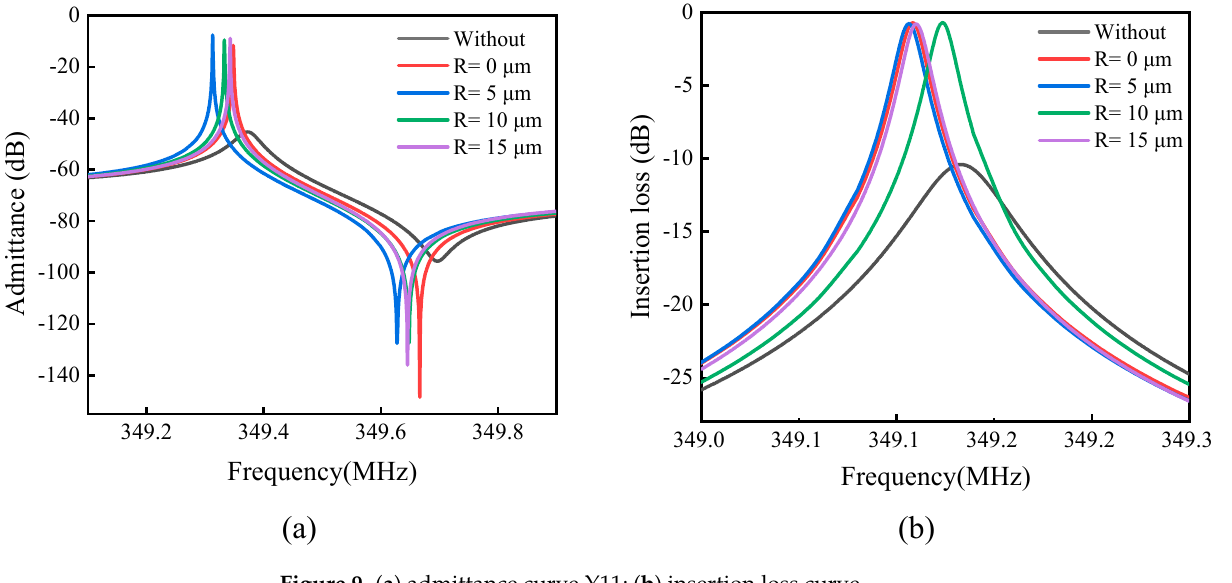
Figure 9. ( a ) admittance curve Y11; ( b ) insertion loss curve.